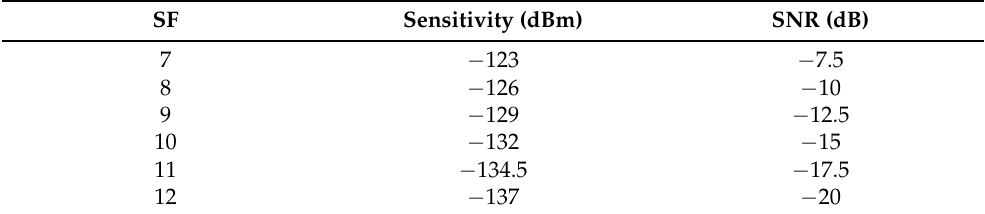
Table 1. SNR values for different spreading